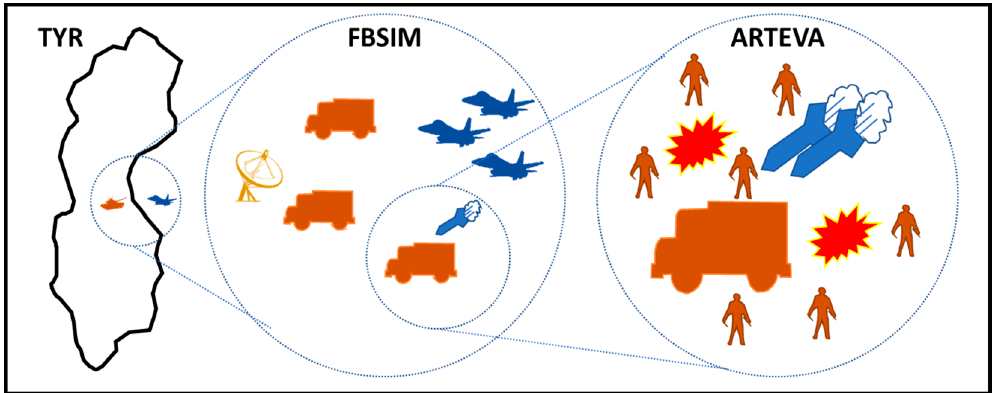
Figure 12. DMIF test/evaluation conceptual architecture (adapted from [42]). Ref. [43] describes the Swedish Defense Research Establishment project that is working on the problem of applying the HLA concept to interoperating simulation models on different levels of resolution. Three legacy models were used to build a federation: ARTEVA, FBSIM and TYR. The